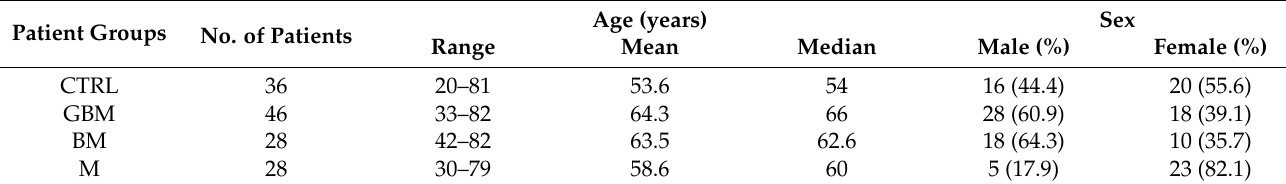
Table 1. Patient